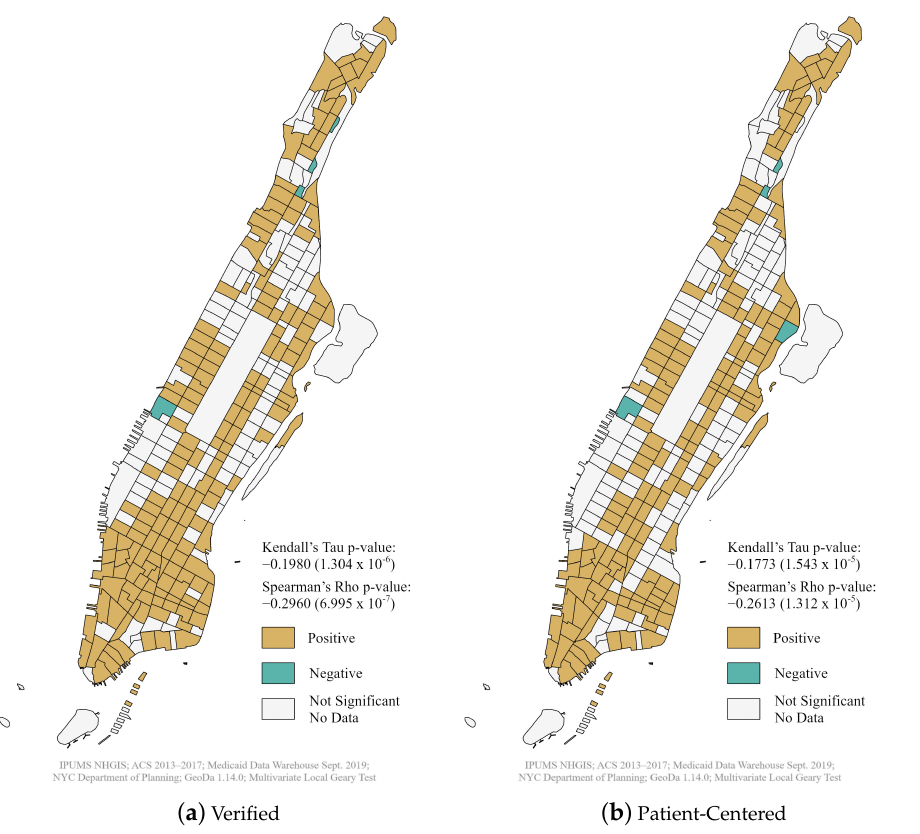
Figure 2. Multivariate Local Geary’s Test of dental supply and poverty in Manhattan census tracts, October